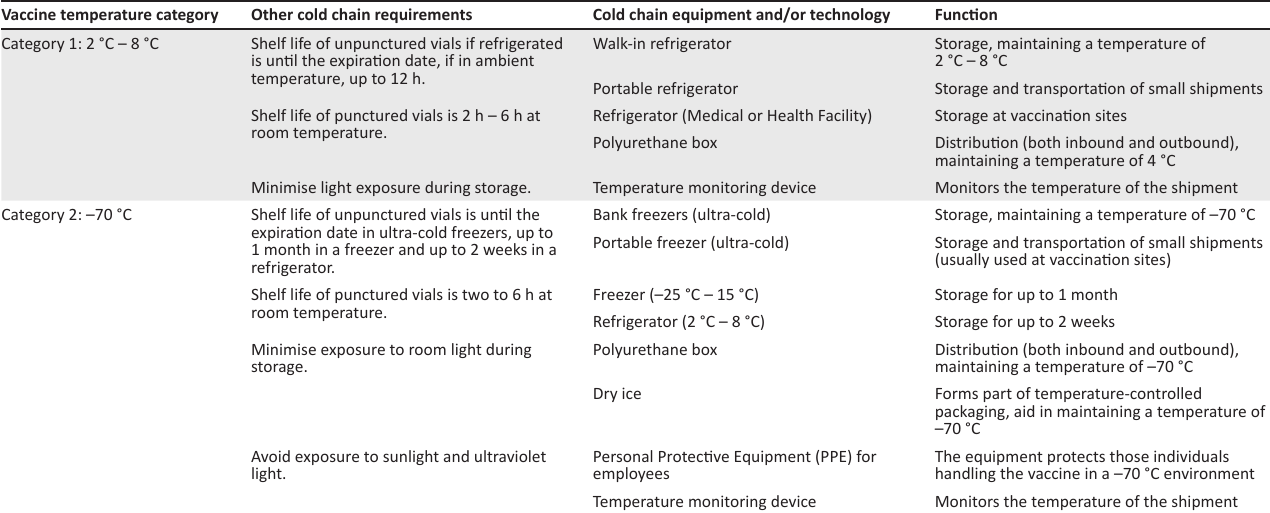
TABLE 2: COVID-19 vaccine categorisation (Toolkit element 2). Vaccine temperature